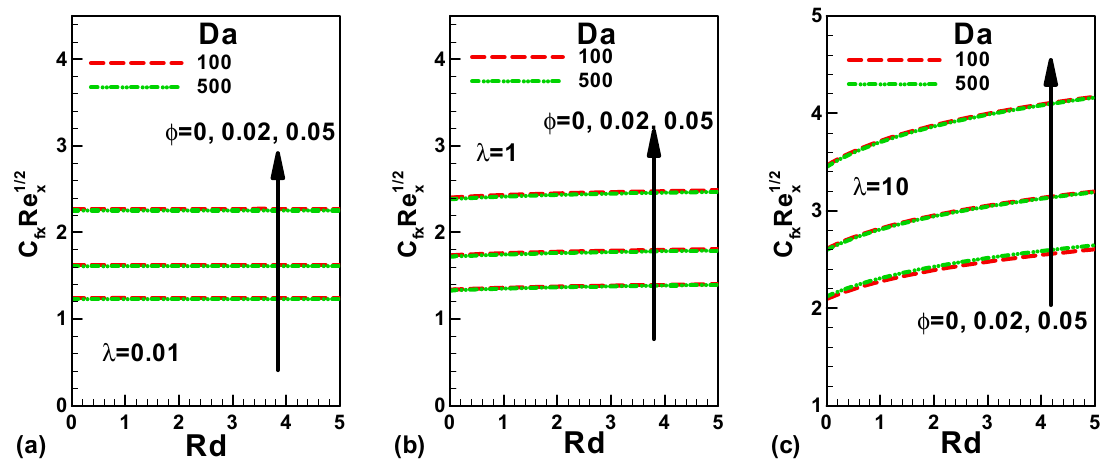
Figure 9. Variation of skin friction with Rd , Da , and ϕ for ( a ) forced convection, ( b ) mixed convection, and ( c ) free convection. [ n = 0.5, Ω = π /6, K = 2, m = 1].